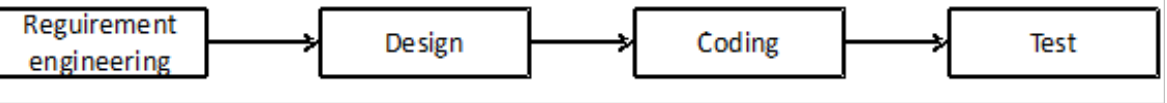
Figure 1. A plan/template for handling a situation when there is a need to develop a customized software